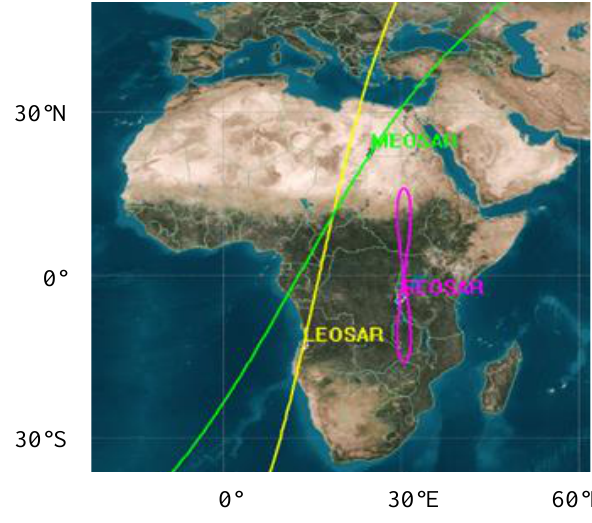
Figure 6. Nadir-point tracks of LEO SAR, MEO SAR, and GEO SAR (by STK). Table 2. Parameters for InSAR processing